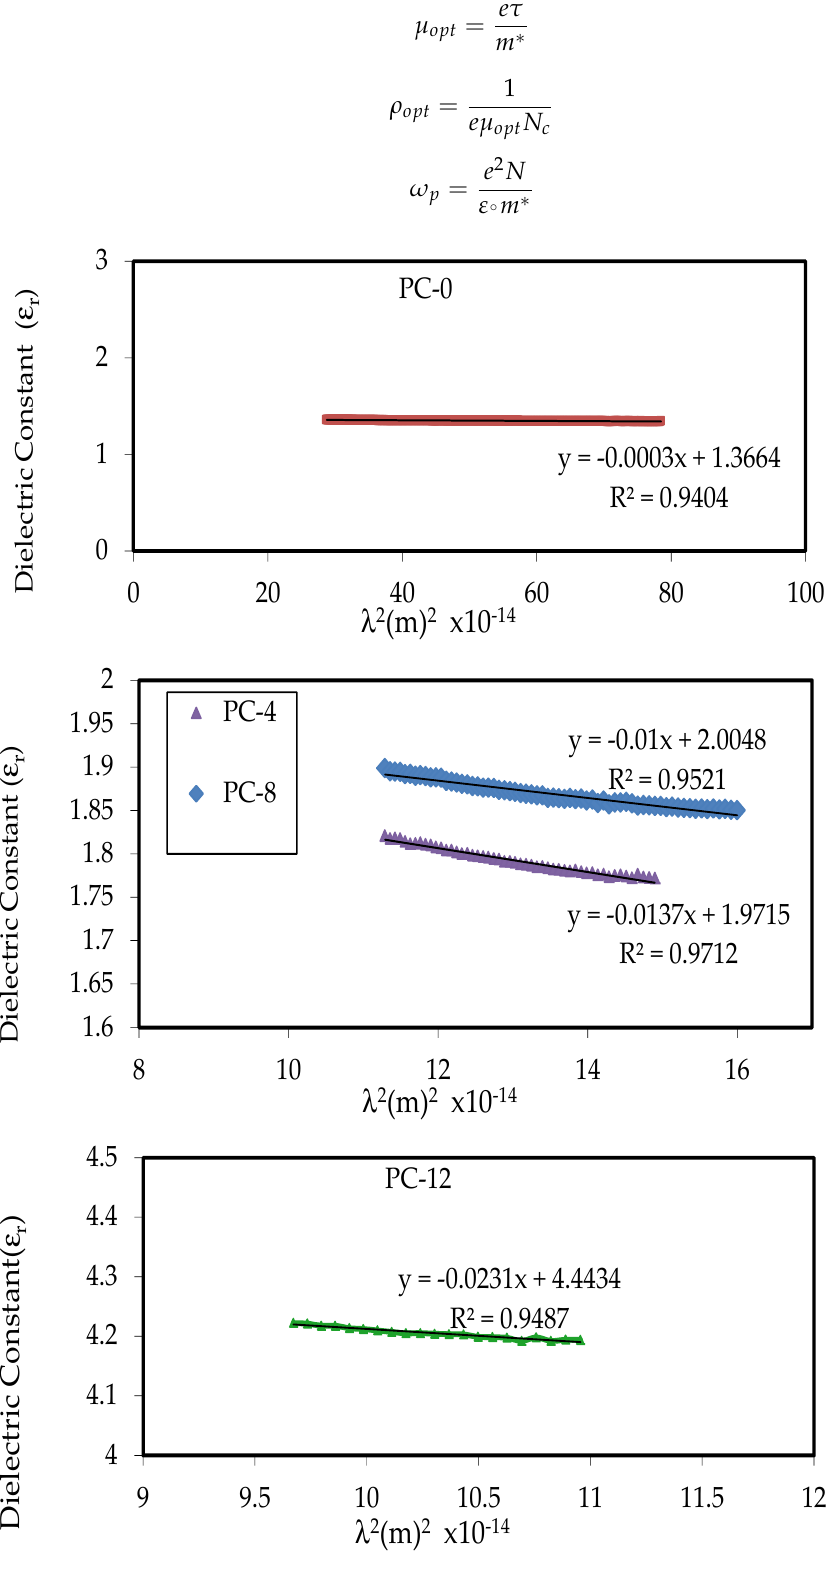
Figure 11. Linear plots of ε r versus λ 2